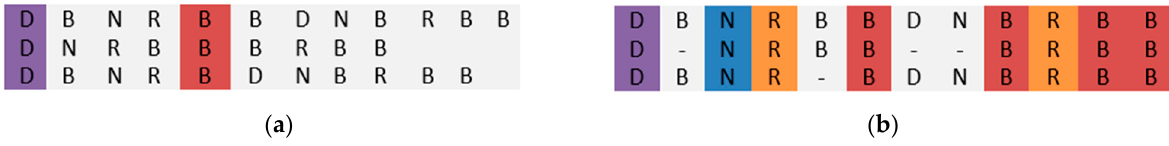
Figure 3. Visual representation of the sequences of activities (the activities are represented as different colored boxes): ( a ) unaligned sequences; ( b ) aligned sequences.